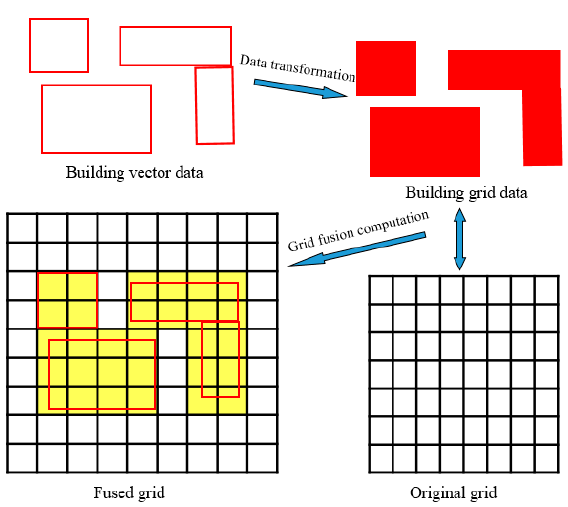
Figure 7. DEM amendment based on building heights.